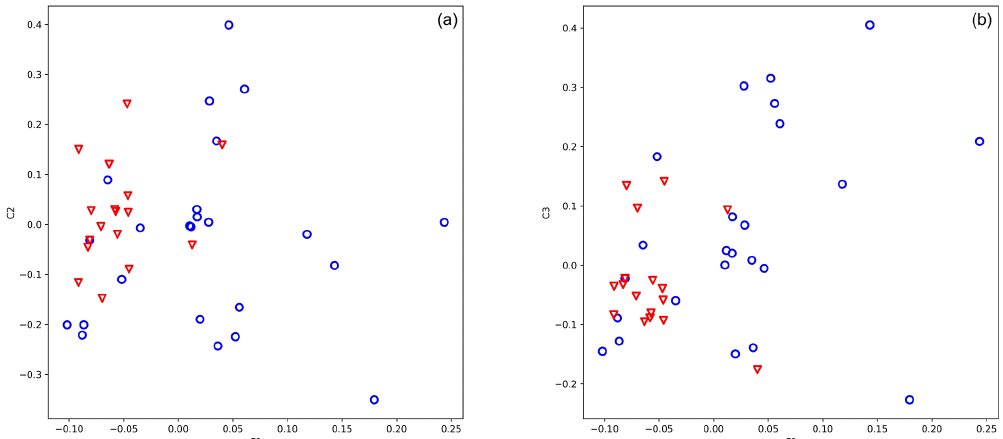
Figure 2. Principal component analysis of 49 stags based on their 14 loci selected to differentiate by antler quality. The blue circle shows animals with low antler quality, and the red triangle shows animals with high antler quality. Eigenvalues of axes C1 and C2 are 9.857 and 5.637,